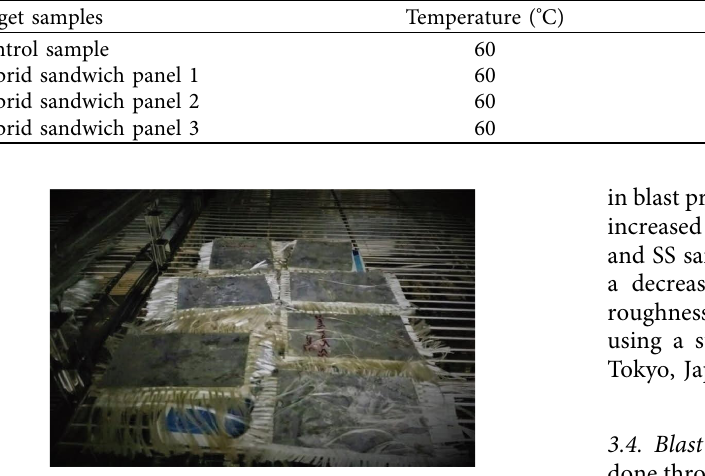
Figure 2: Prepared sandwich composite panels in artifcial weathering